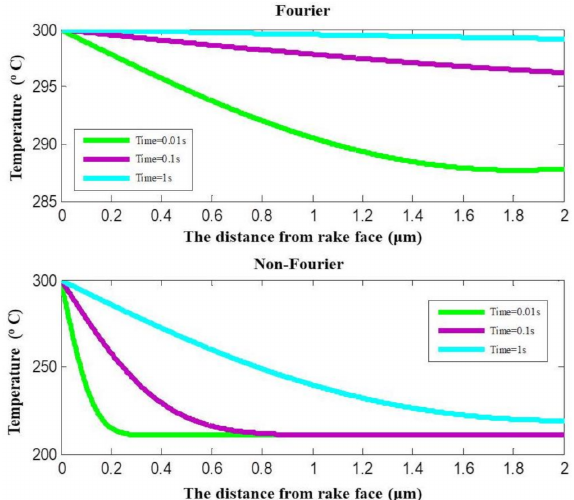
Figure 8. Temperature prediction with Fourier and non-Fourier heat conduction.